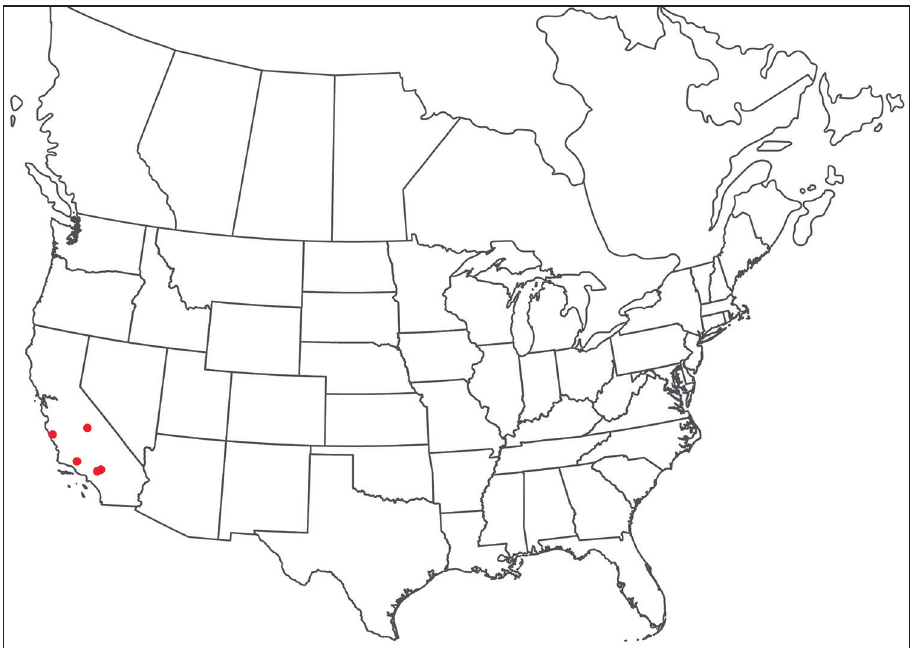
Figure 278. Torrenticola wiedenmanni